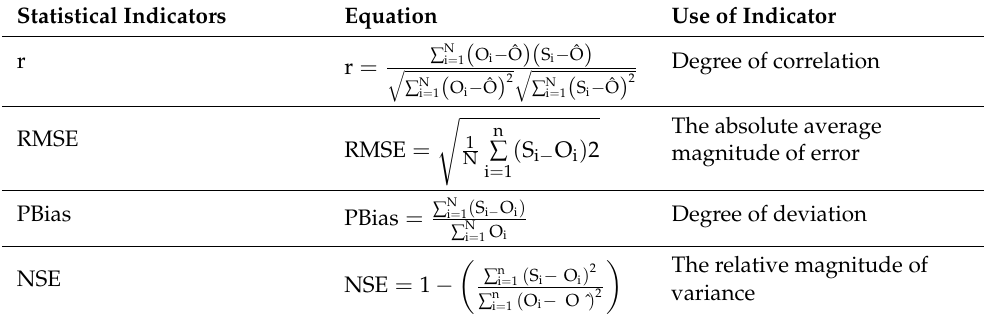
Table 4. Continuous Evaluation Indices.